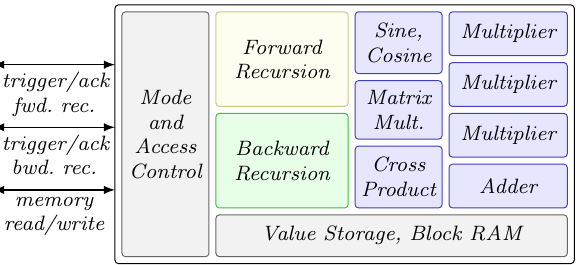
Fig. 6 Internals of the implemented VHDL component LinkDyn to compute the dynamics of a single node on a